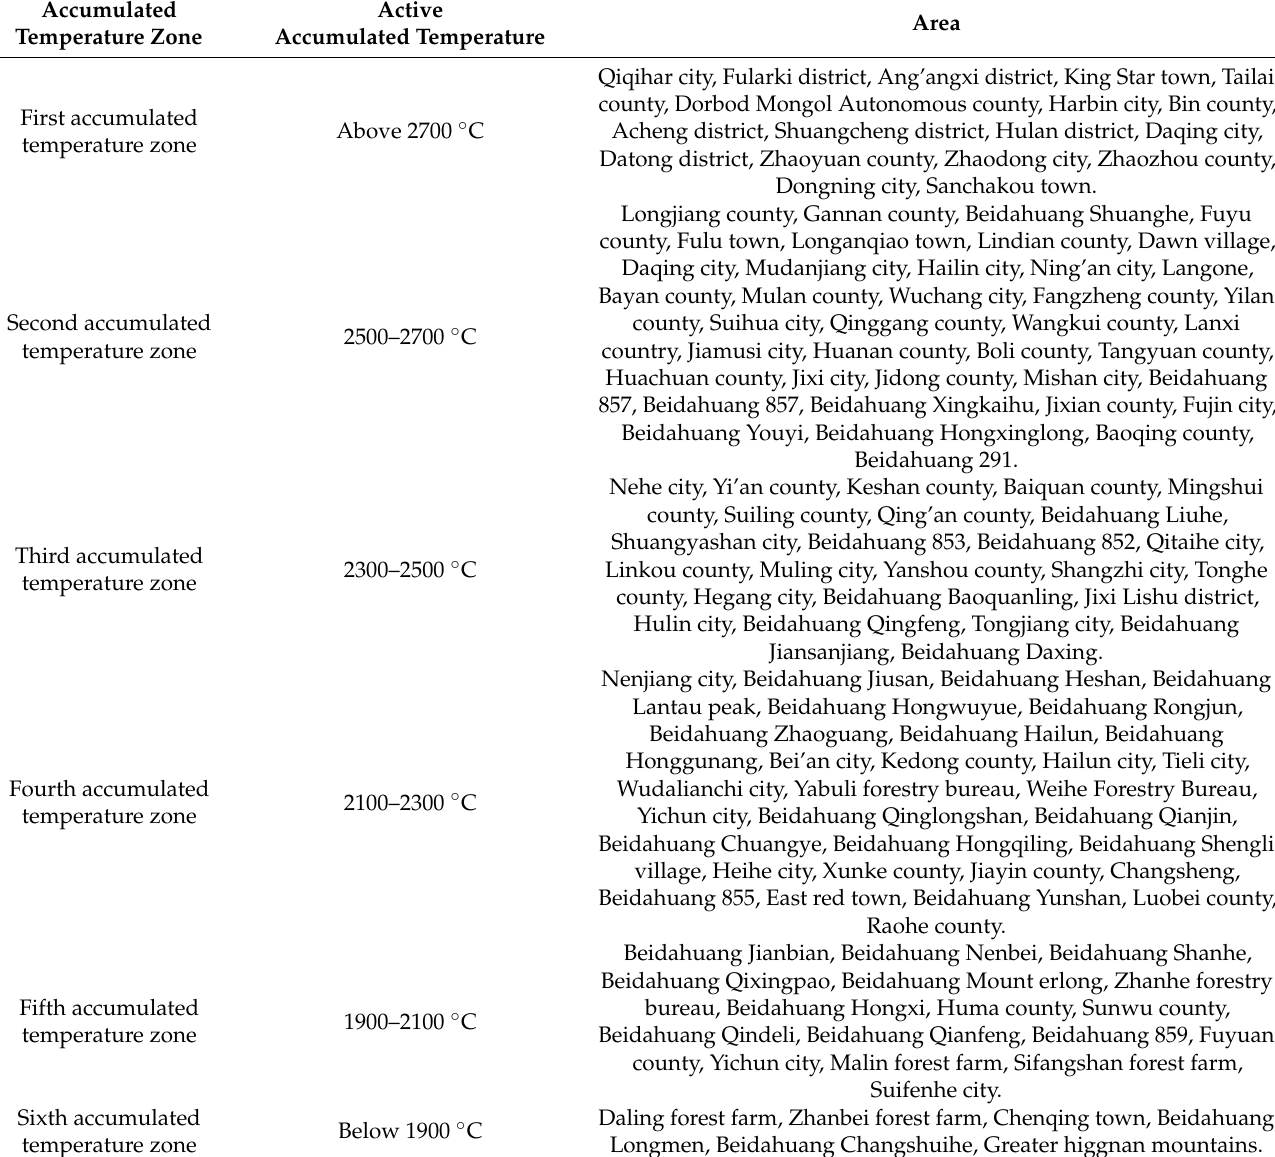
Table 6. A breakdown of the division of the Heilongjiang temperate